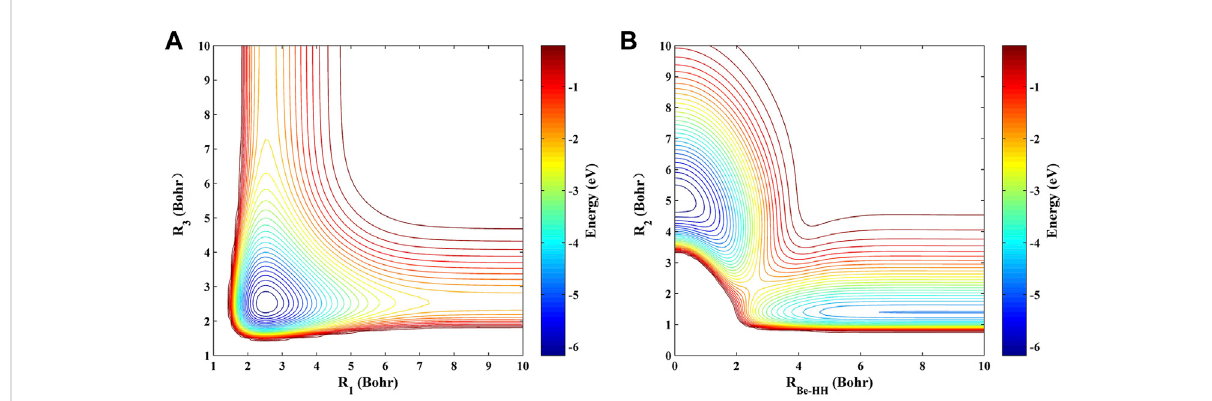
FIGURE 3 Contour plots of the ground-state BeH 2 PES at the (A) D ∞ h and (B) C 2 v symmetries.